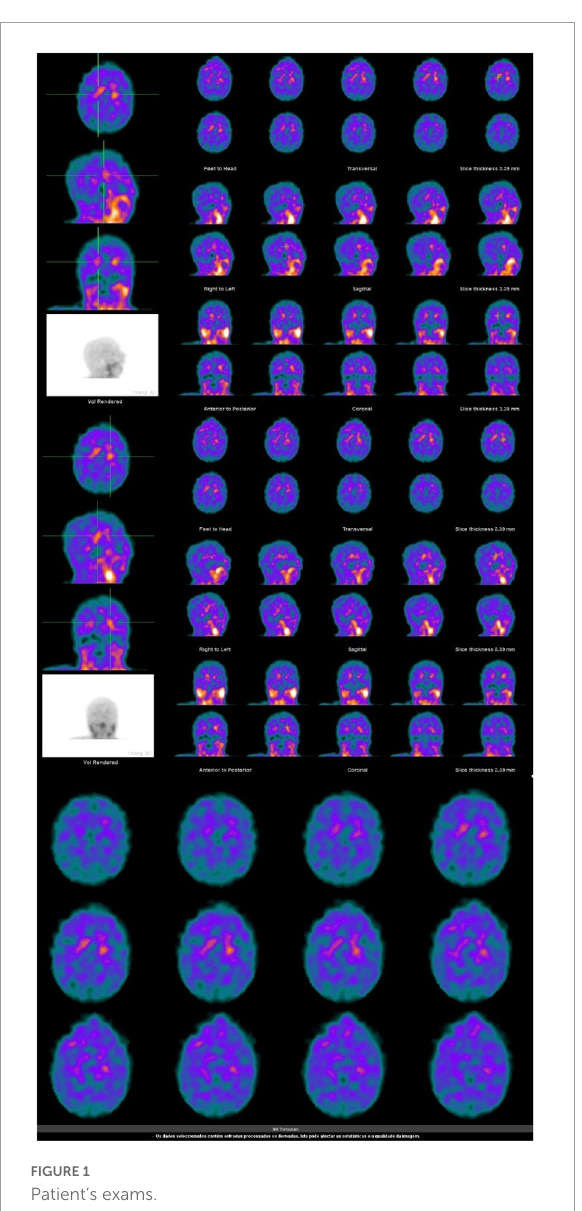
FIGURE1 Patient’s